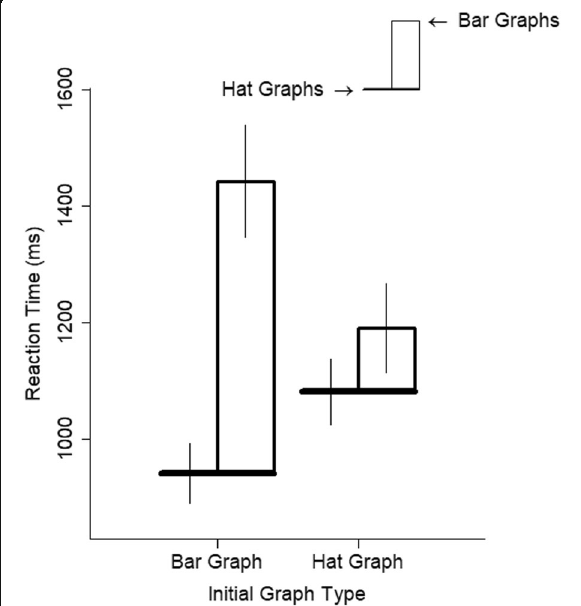
Fig. 5 Reaction time (RT) is plotted as a function of graph type and start condition for experiment 1. The brim of the hat corresponds to the RTs for the hat graph condition, and the top of the crown of the hat corresponds to RTs for the bar graph condition. The size of the crown indicates the difference in RTs between the two conditions.